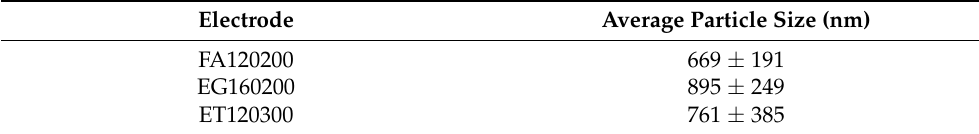
Table 2. Average particle size for the Pt@GDL electrodes